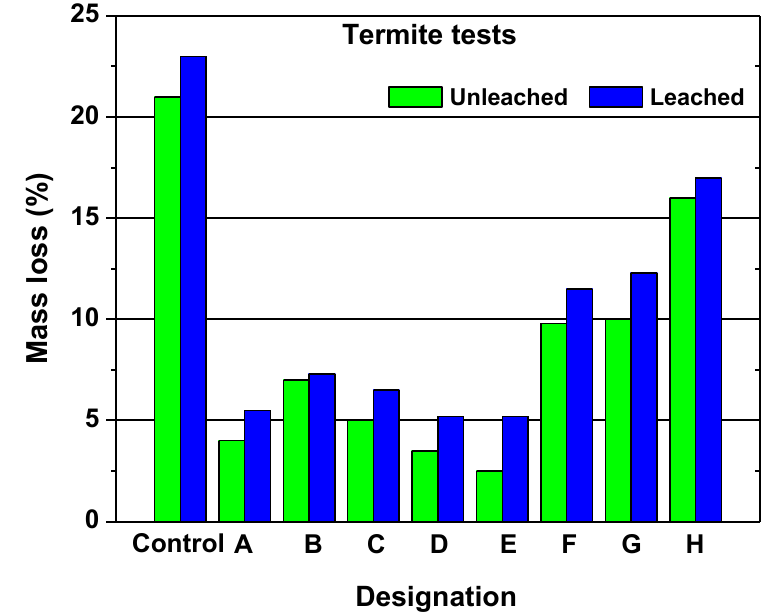
Figure 5. The mass loss (%) following termite resistance for leached and unleached pine wood: ( A ) nanozinc oxide; ( B ) nanozinc oxide plus binder A; ( C ) nanozinc oxide plus binder B; ( D ) nanozinc borate; ( E ) nanozinc borate plus binder A; ( F ) nano-copper oxide; ( G ) nano-copper oxide plus binder A; and ( H ) nano-copper oxide plus binder B. Reprinted with permission from [78], Copyright Elsevier, 2014.